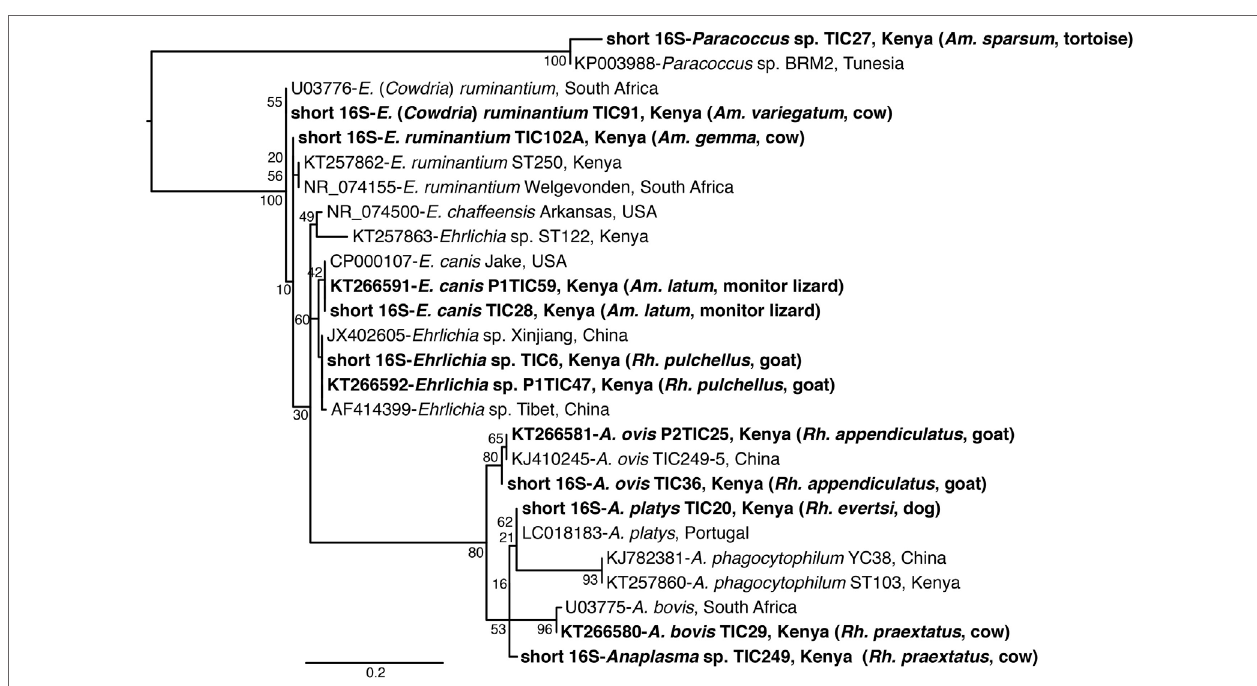
FigUre 3 | Maximum likelihood phylogenetic analysis of 16s rrna gene fragments of Anaplasma , Ehrlichia , and Paracoccus sequences identified with related sequences . GenBank accession numbers, species identifications, isolates, and country of origin are indicated for each 16S rRNA gene sequence. Sequences from this study are in bold with tick and vertebrate host species associated with the study isolates indicated in brackets. Bootstrap values at the major nodes are of percentage agreement among 1,000 replicates. The branch length scale represents substitutions per